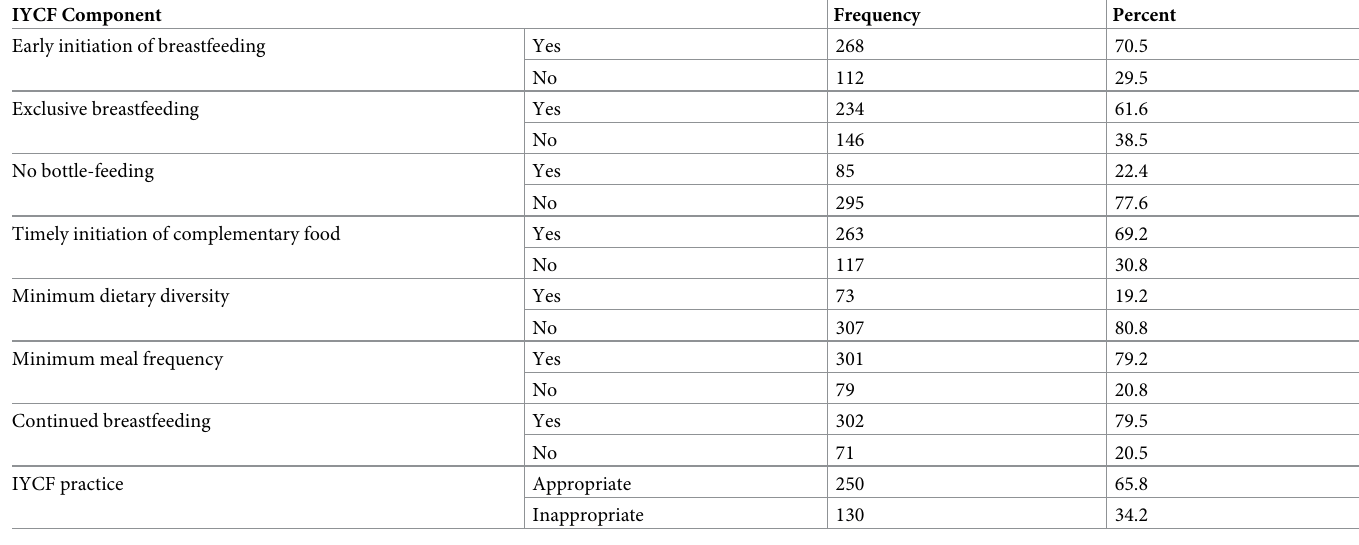
Table 3. Infant and young child feeding practice components among mothers with children age between 6 to 23 months at Debrelibanos district, north Showa, Oro- mia, Ethiopia. IYCF